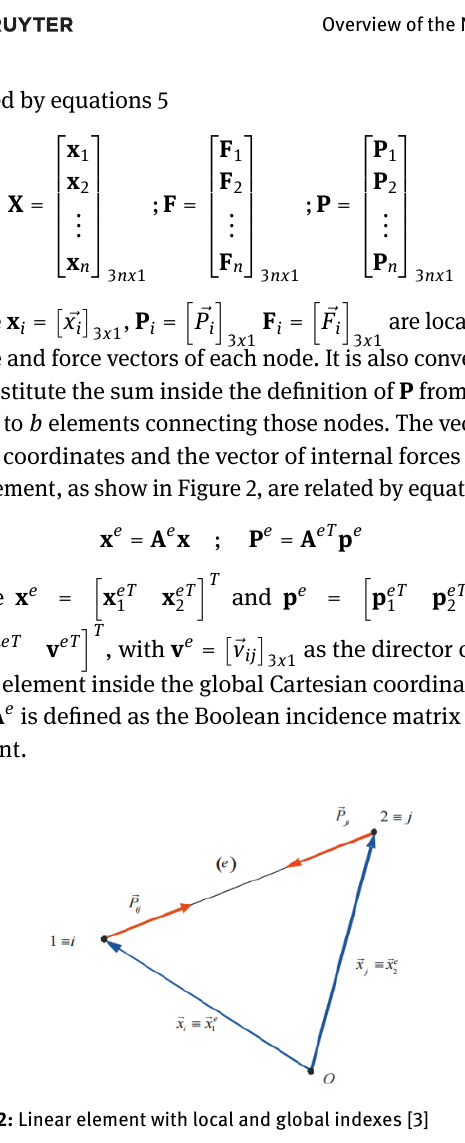
Once these definitions are given, the equation 4 can be rewritten as equation 7, where K force density stiffness matrix of the system, with k e in equation 8 is the element local stiffness matrix, with n e as the element force density and I matrix.